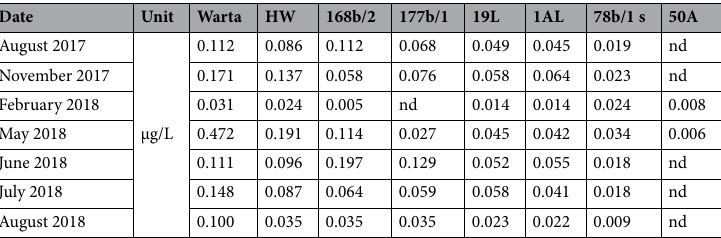
Table 3. Total concentrations of pesticides at each sampling point in all sampling campaigns, nd not detected.